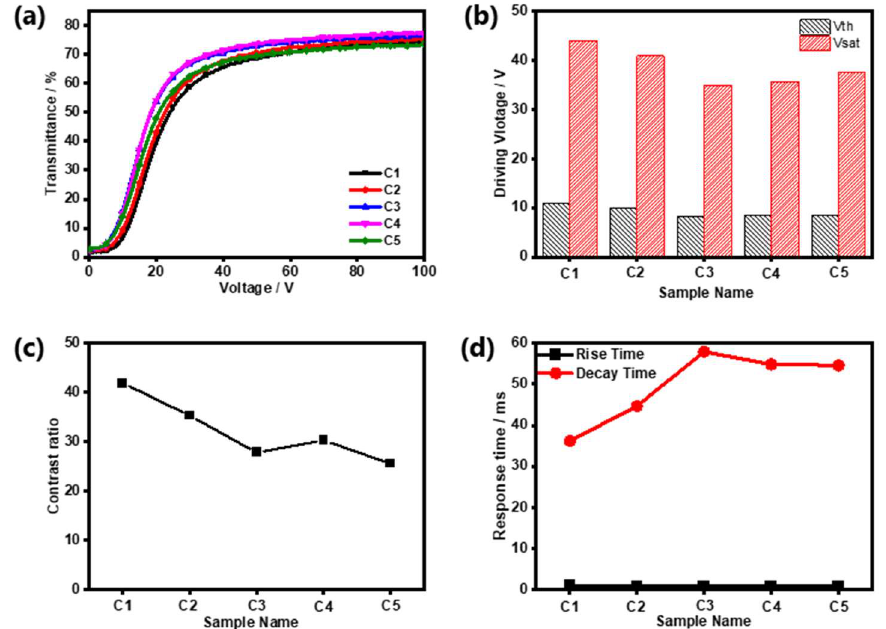
Figure 6. ( a ) Transmittance as a function of applied voltage (at 100 Hz frequency); ( b ) bar graph for threshold voltages ( V th ) and saturations voltage ( V sat ); ( c ) contrast ratio ( CR ) and ( d ) response time of Samples C1–C5.